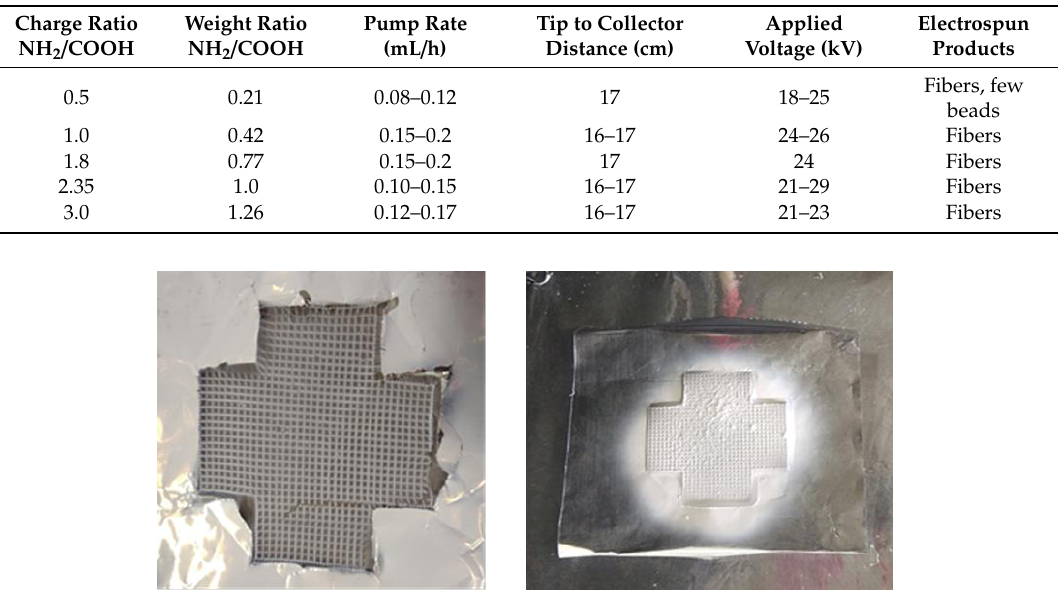
Figure 12. CS / HA + polyethylene oxide (PEO) nanofibers on metallic collectors utilized for the Figure 12. CS/HA+ polyethylene oxide (PEO) nanofibers on metallic collectors utilized for the electrospinning process. electrospinning process.